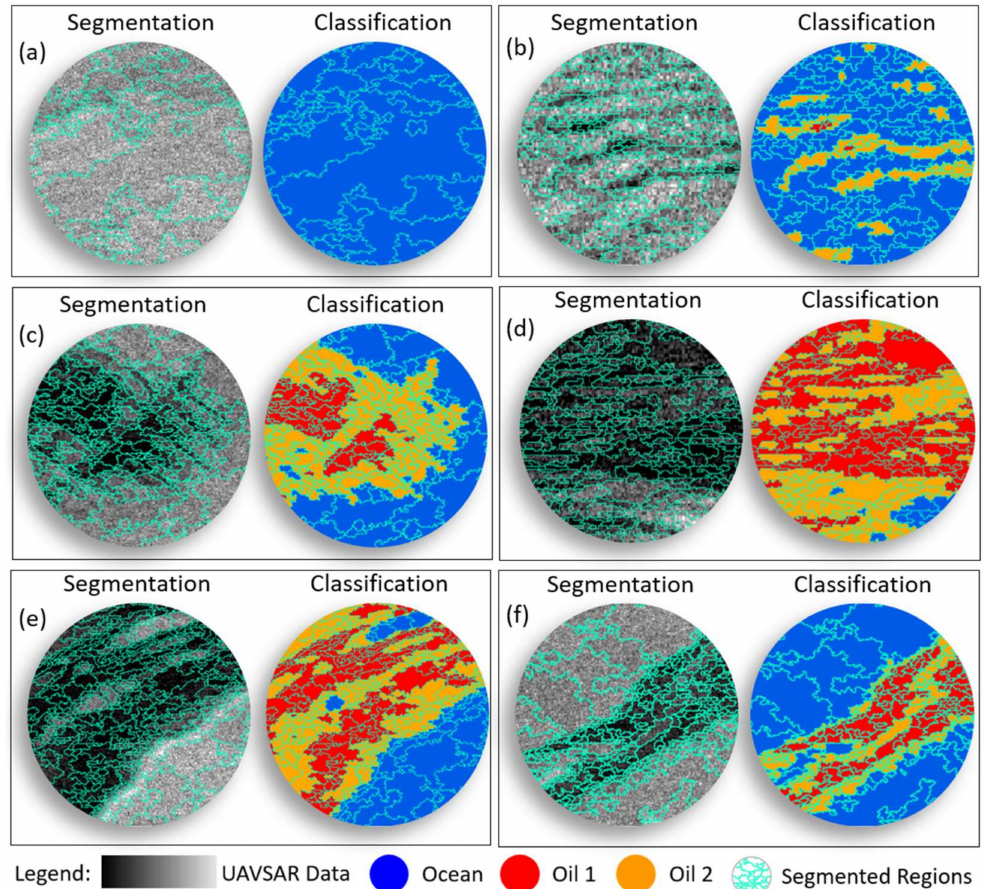
Figure 7. Oil slick characterization illustrating details of the segmented and classified regions over: ( a ) slick-free ocean regions, and; ( b – f ) oil slick covered regions with different thicknesses, sizes and